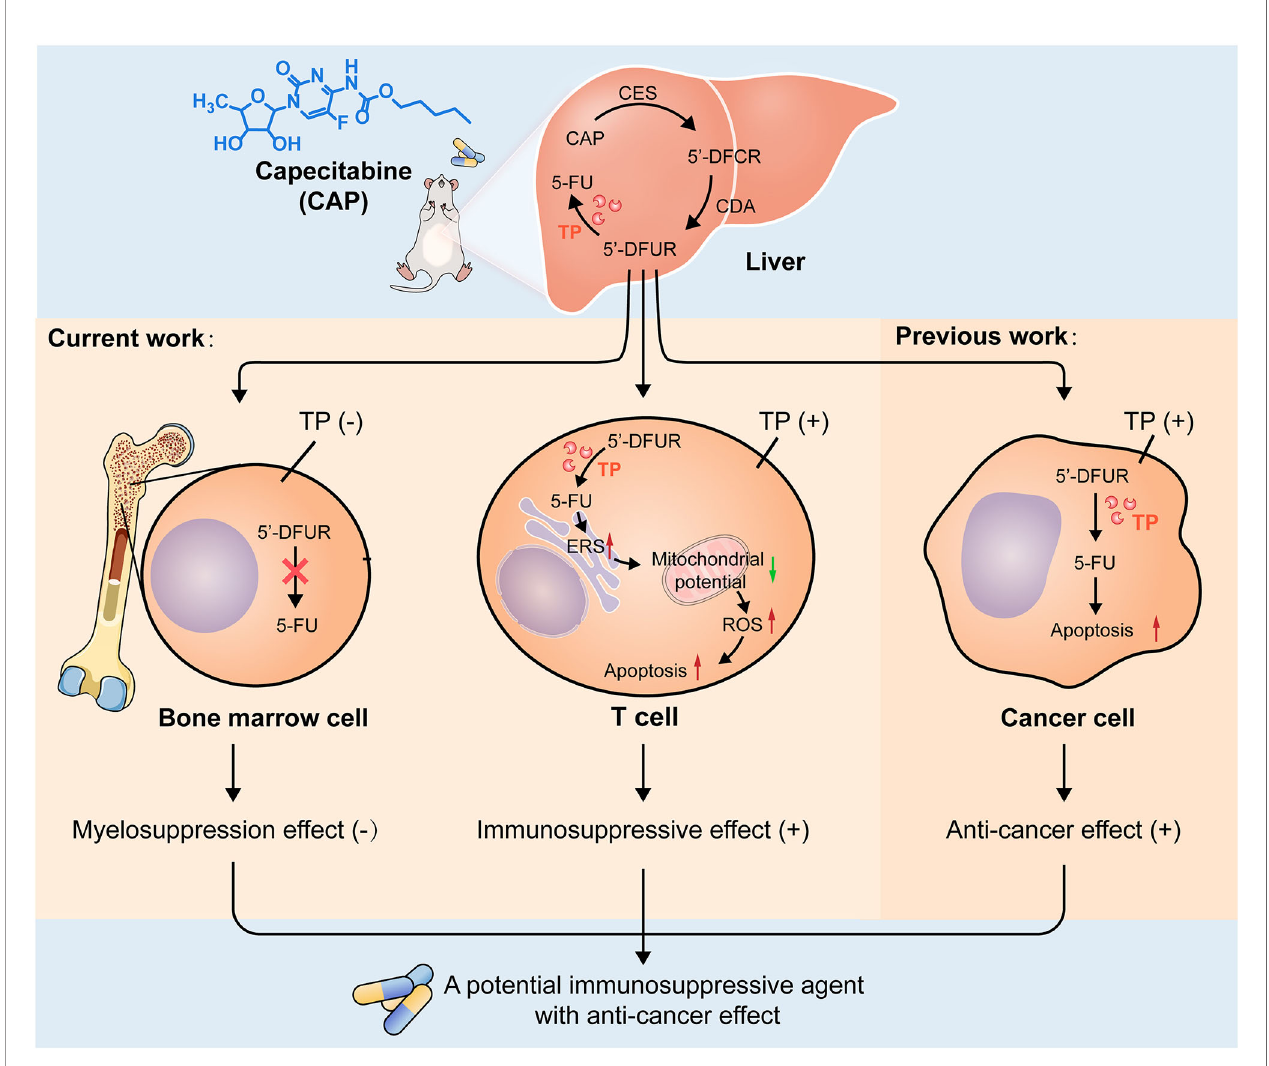
FIGURE 8 | Possible mechanisms of CAP as a drug with both immunosuppressive and anti-cancer effects. After oral administration, CAP is converted into 5 ′ DFCR and 5 ′ DFUR in the liver by CES and CDA. There is no expression of TP in bone marrow tissue; thus, capecitabine cannot be converted into 5-FU, which circumvents myelosuppression and predicts the feasibility of its long-term medication. TP is expressed in T cells, and capecitabine can be converted into 5-FU there; thus, CAP increases endoplasmic reticulum stress response, reduces the membrane potential of mitochondria, increases the expression of ROS, fi nally, mitochondria-mediated apoptosis was induced. TP is also expressed in cancer cells, and CAP can induce cancer cell apoptosis and exert anti-cancer effect; this indicates that apoptosis is the fi nal destination of CAP acting on T cells and cancer cells, both of which express TP, which lays an experimental foundation for exploring CAP as a drug with both immunosuppressive and anti-cancer